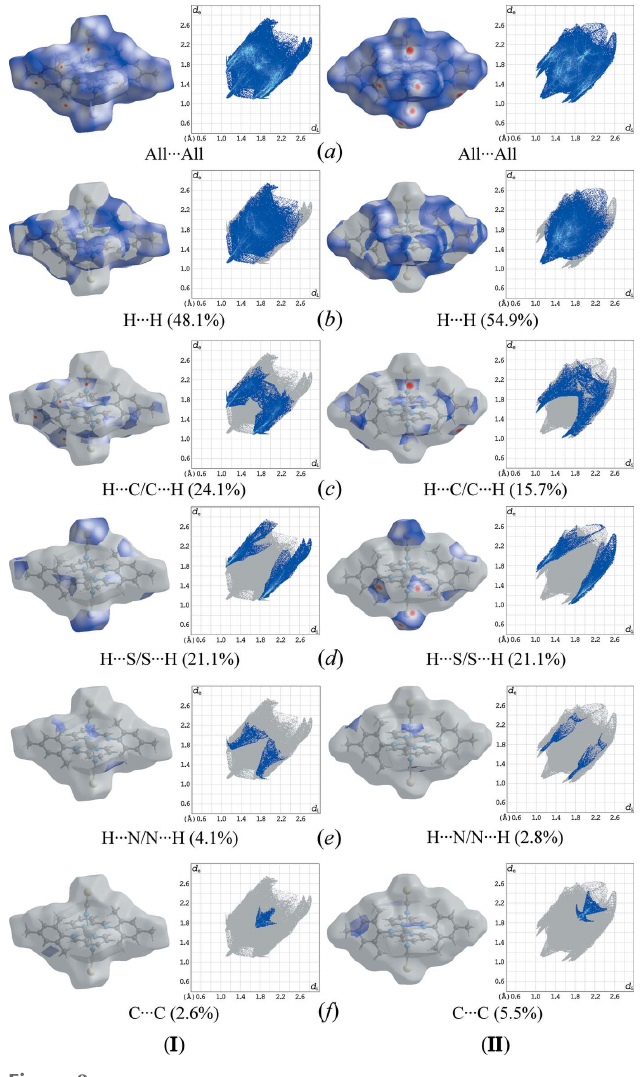
Figure 8 Two-dimensional fingerprint plots of ( I ) and ( II ), showing ( a ) all interactions, and those delineated into ( b ) H (cid:4)(cid:4)(cid:4) H, ( c ) H (cid:4)(cid:4)(cid:4) C/C (cid:4)(cid:4)(cid:4) H, ( d ) H (cid:4)(cid:4)(cid:4) S/S (cid:4)(cid:4)(cid:4) H, ( e ) H (cid:4)(cid:4)(cid:4) N/N (cid:4)(cid:4)(cid:4) H, and ( f ) C (cid:4)(cid:4)(cid:4) C contacts [ d e and d i represent the distances from a point on the Hirshfeld surface to the nearest atoms outside (external) and inside (internal) the surface, respectively].